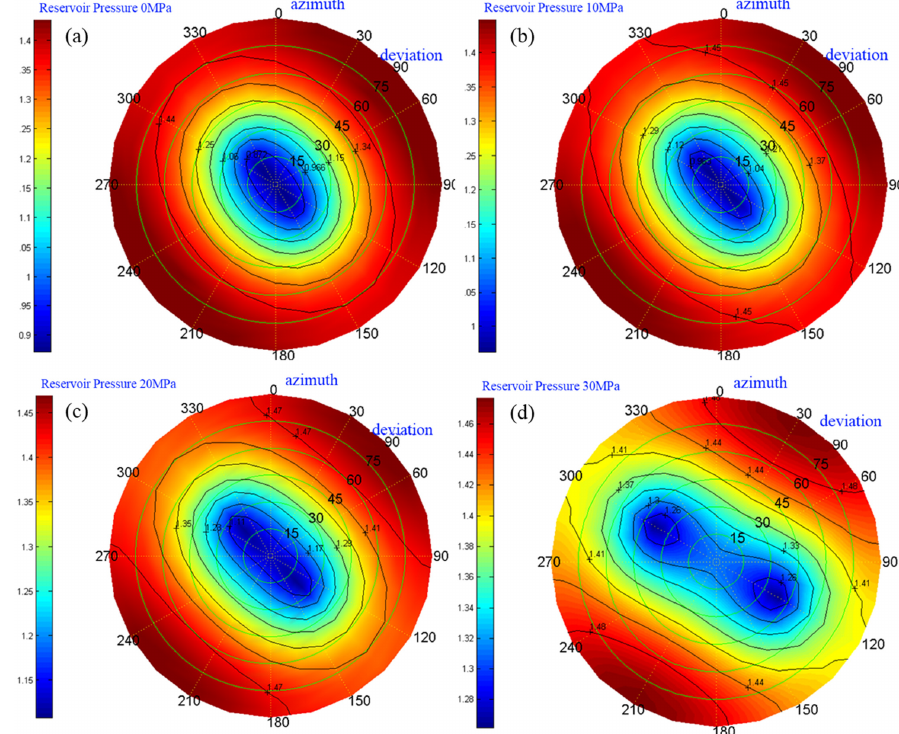
Figure 9. Reservoir collapse pressure change law of any well with pressure decline. ( a – d ) are represent reservoir pressure from 0 MPa to 30 MPa, respectively.